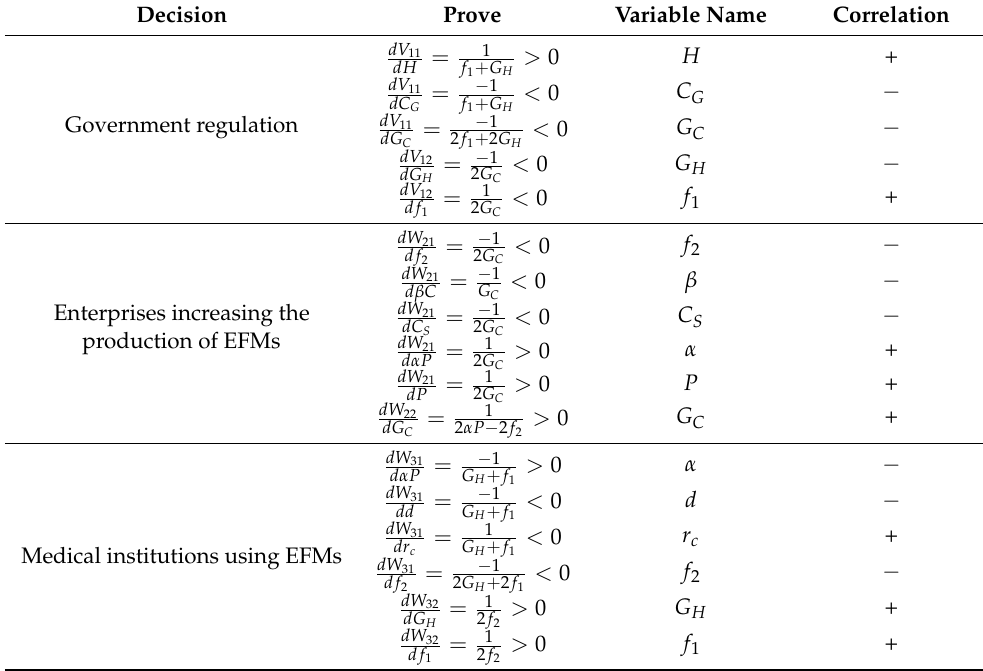
Table 3. Parameter influence. Decision Prove Variable Name